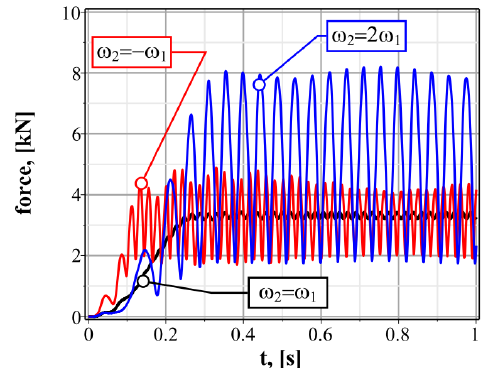
Figure 7. Time dependencies of the disturbing force of the inertial vibration exciter at different ratios between the angular speeds of the unbalanced rotors.